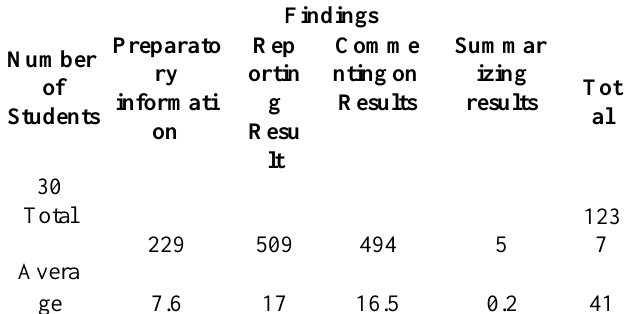
TABLE 3 | Results of mastery of rhetorical structures in the English thesis results